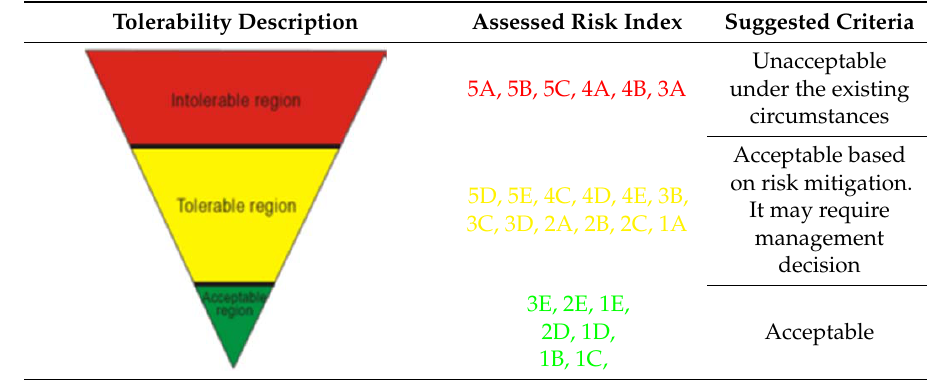
Table 6. Safety tolerability risk matrix